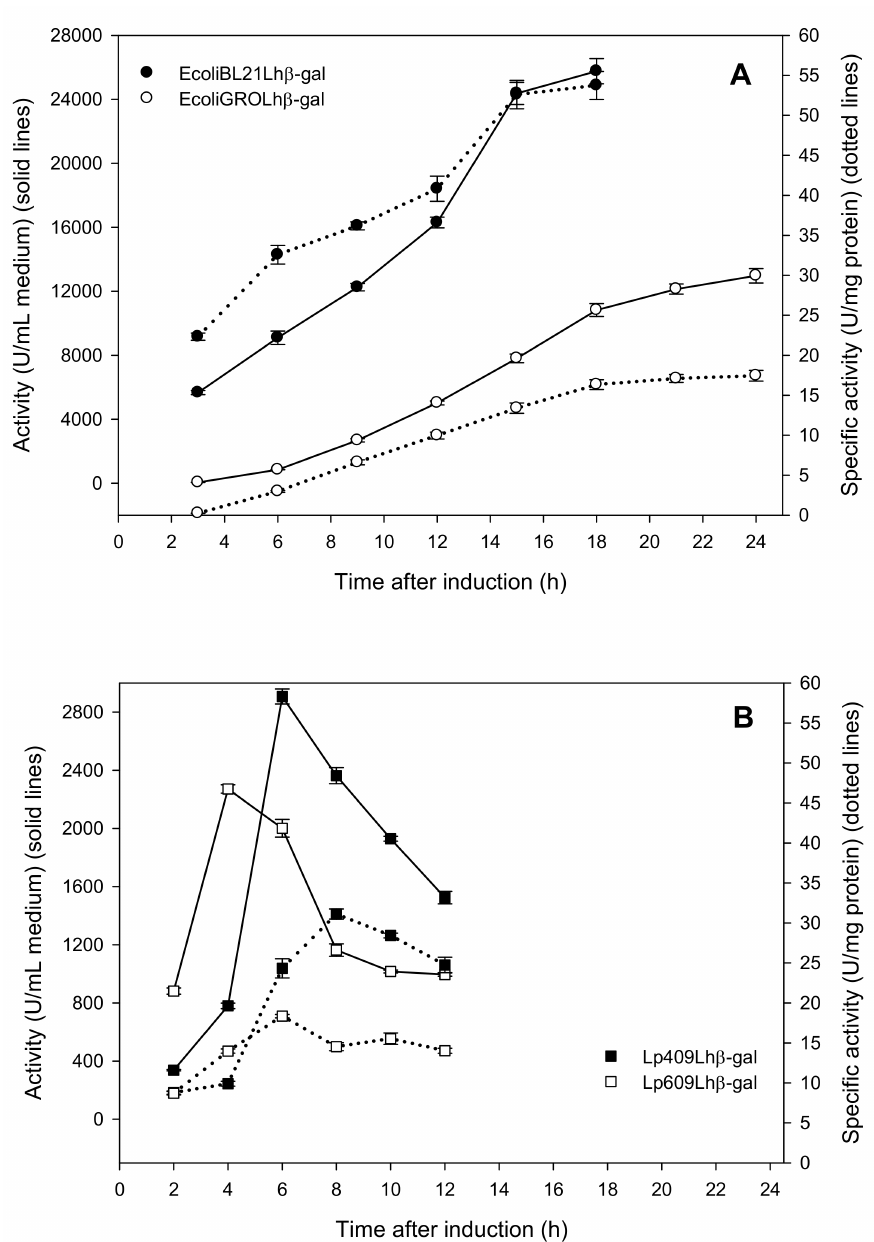
Figure 2. Time course of the cultivations of ( A ) E. coli BL21 Star (DE3) and E. coli T7 Express containing the plasmid pGRO7 and ( B ) L. plantarum WCFS1 and L. plantarum TLG02 overexpressing β -galactosidase from L. helveticus DSM 20075, resulting in the recombinant β -galactosidases EcoliBL21Lh β -gal, EcoliGROLh β -gal, Lp409Lh β -gal and Lp609Lh β -gal, respectively. All data points represent the average value from two independent experiments, and the percentage error was always less than